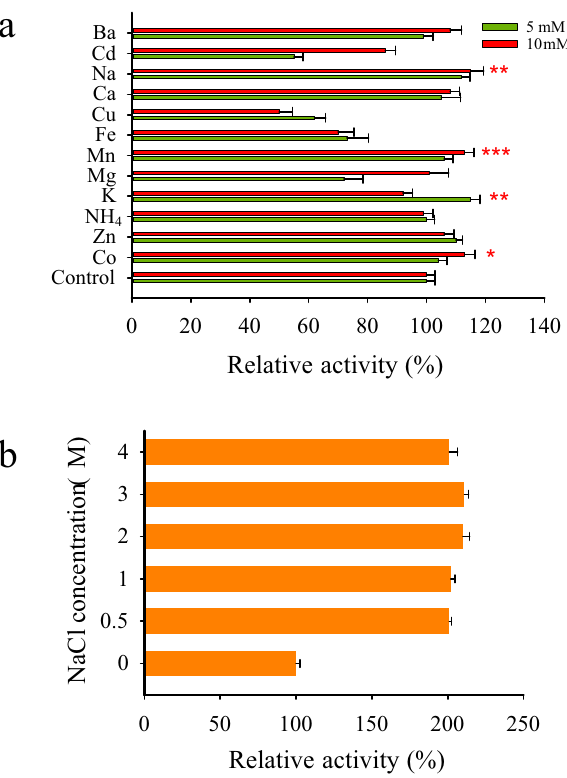
Figure 3. ( a ) Relative activity of Xyn-2 in the presence of various cations at 5 mM and 10 mM concentrations. The amount of enzyme activity in the absence of the cations (control) was taken as 100% and the activity in the presence of each cation was expressed relative to that. ( b ) Influence of NaCl at high concentrations on Xyn-2 activity. The amount of enzyme activity in the absence of NaCl (control) was taken as 100% and the activities obtained in various concentrations of NaCl were expressed as a percentage to that. All reactions were performed at 20 °C, in citrate buffer (pH 5). The stars indicate a significant increase in the enzyme activity at p ≤ 0.001 (***), p ≤ 0.01 (**), and p ≤ 0.05 (*) compared to the